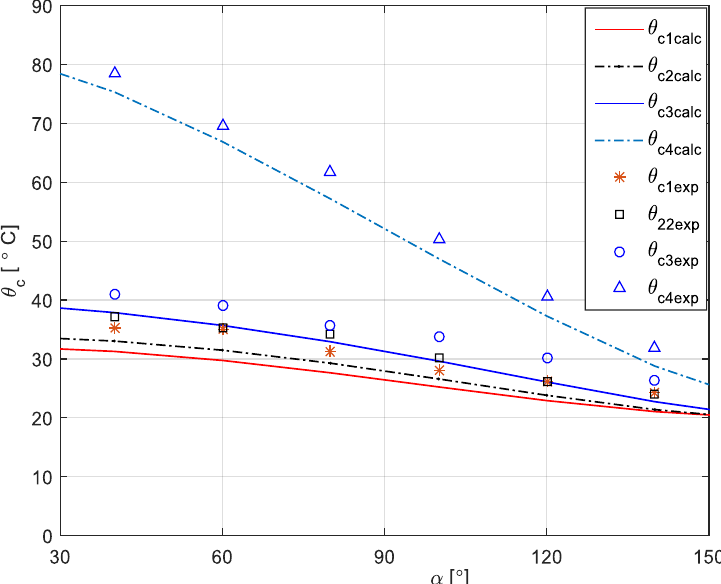
Figure 16. Case temperature variation vs. firing angle at different load inductance values of 18, 30, 55, and 200 mH ( v air = 3 m/s; I = 200 A; R = 10 Ω).